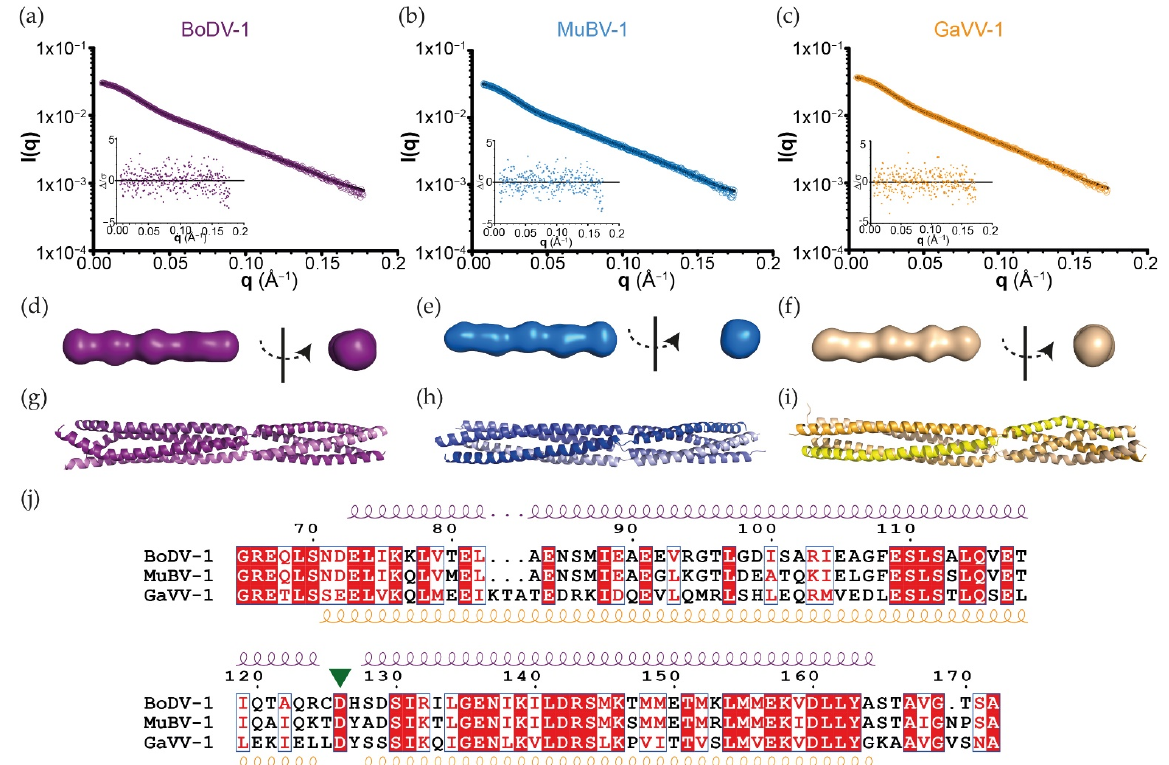
Figure 4. Structural analysis of orthobornaviral P OD . Experimental SAXS diffusion curves (with residuals (small plots)) of ( a ) BoDV-1, ( b ) MuBV-1, and ( c ) GaVV-1 P OD overlaid with the averaged SAXS curves (black) resulting from the ab initio models shown in panels d – f . Low-resolution envelops of ( d ) BoDV-1, ( e ) MuBV-1, and ( f ) GaVV-1 P OD based on the ab initio modelling from the